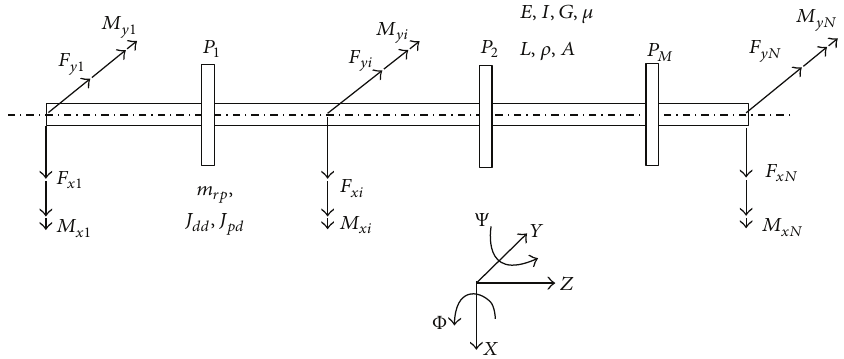
Figure 2: The finite element rotor dynamic model.